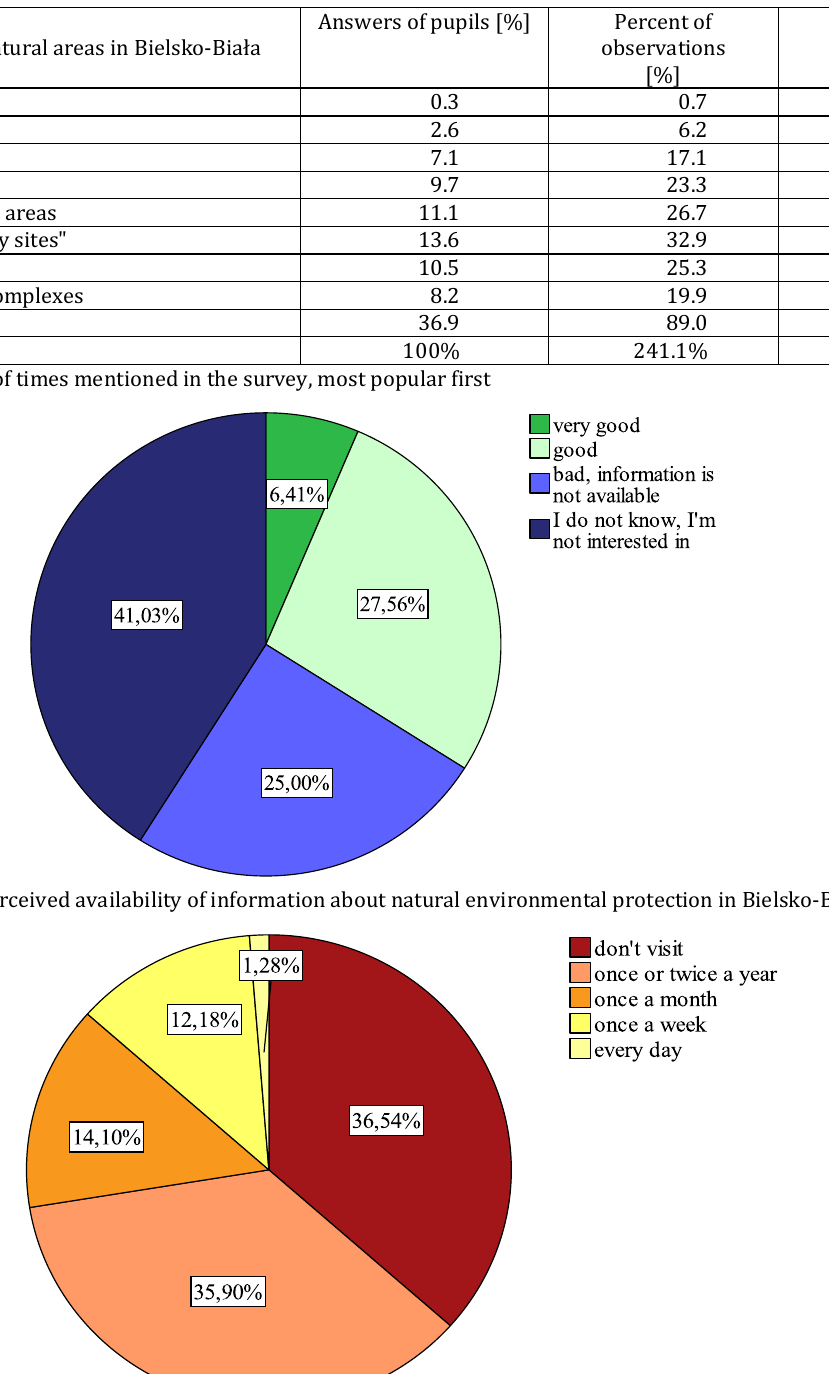
Table 4. Perceptions of high school students